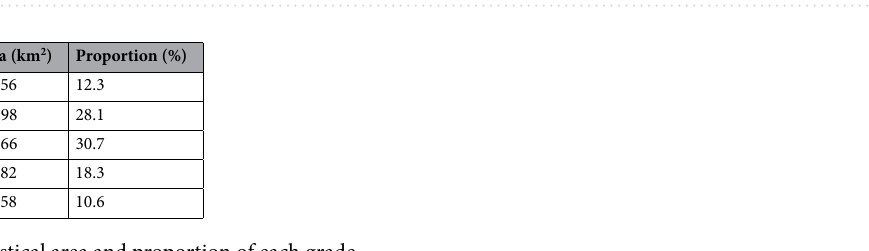
Table 8. Statistical area and proportion of each